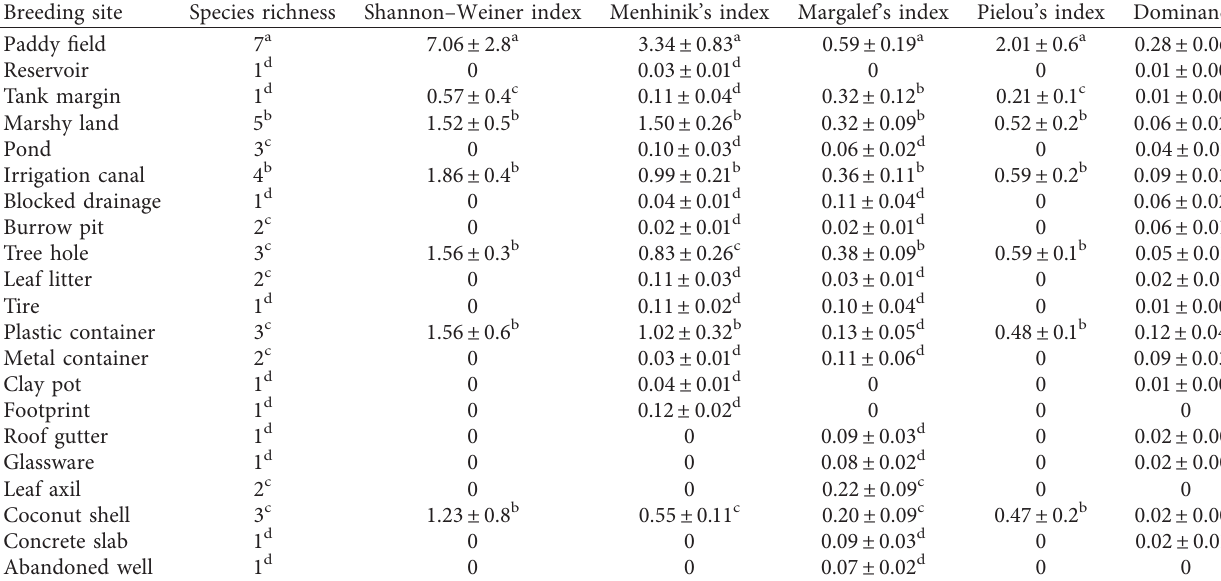
Table 5: Diversity of medically important mosquito species encountered in different breeding habitats across the four